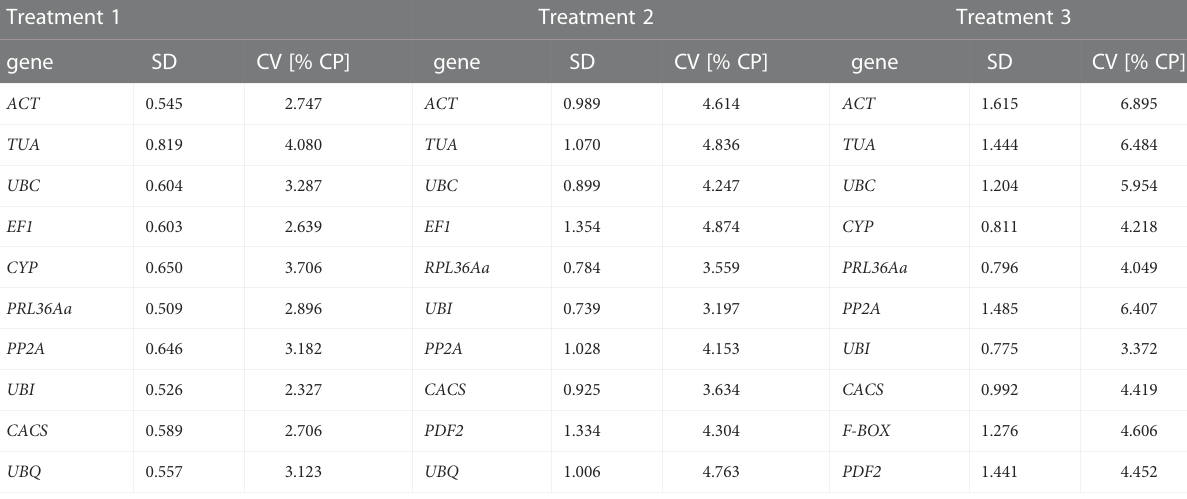
TABLE 3 Candidate genes and their expression stability values calculated by BestKeeper. Treatment 1 Treatment 2 Treatment 3